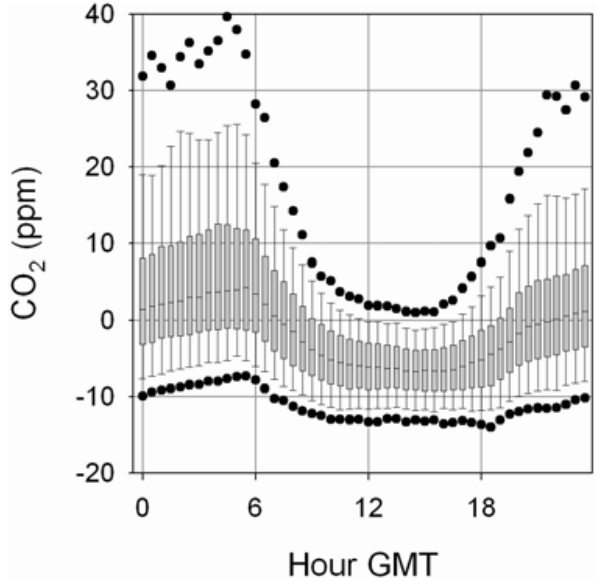
Fig. 7. Box plot showing the daily cycle of detrended CO 2 concen- Figure 7.- Box plot showing the daily cycle of detrended CO trations (from 1 August 2002 to 31 July 2005). August 2002 to 31 July 2005). mixed layer was linked to lower concentrations, whereas the establishment of a ground surface temperature inversion de-